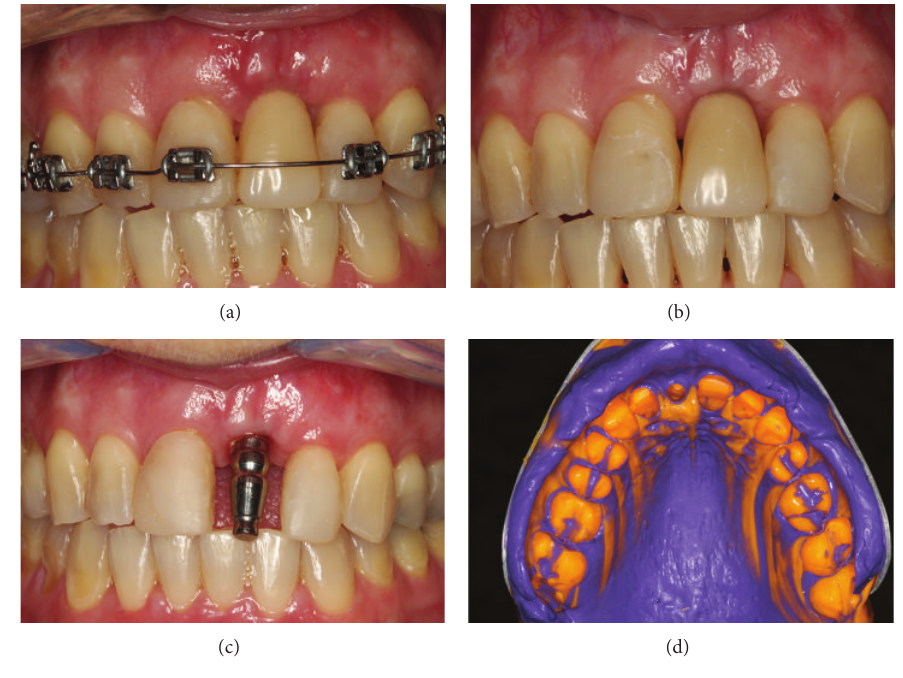
Figure 10: Transfer impression for coping